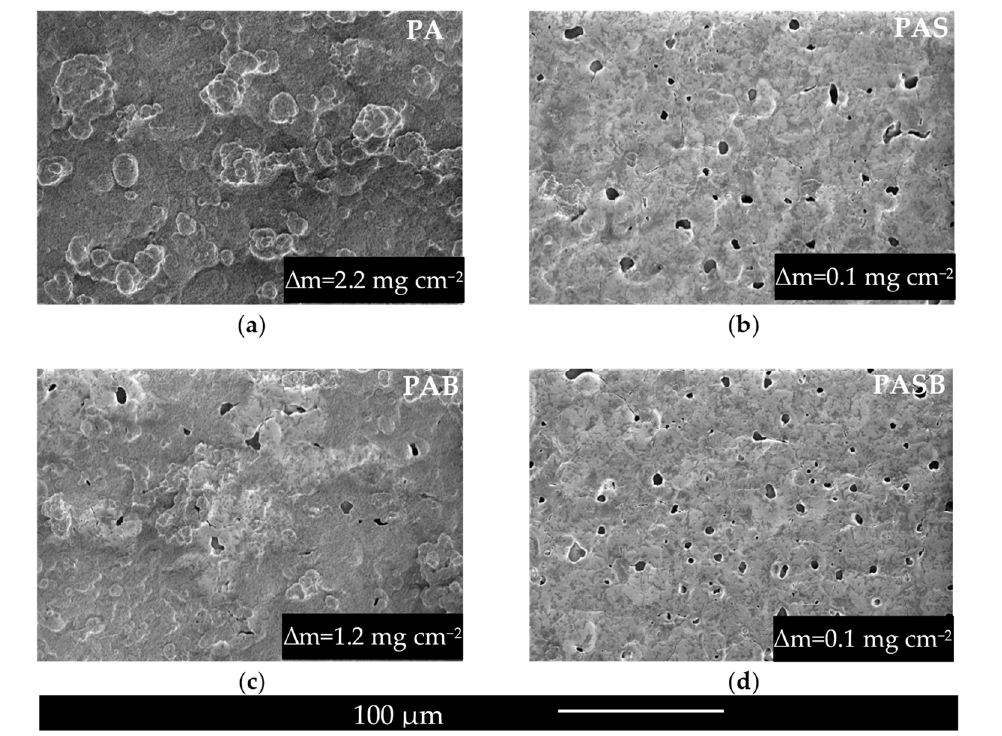
Figure 4. Surface morphologies of the PEO coatings produced in ( a ) PA, ( b ) PAS, ( c ) PAB, ( d ) PASB electrolytes after the SBF test. Table 6. The elemental composition of samples PA, PAS, PAB, and PASB after the SBF